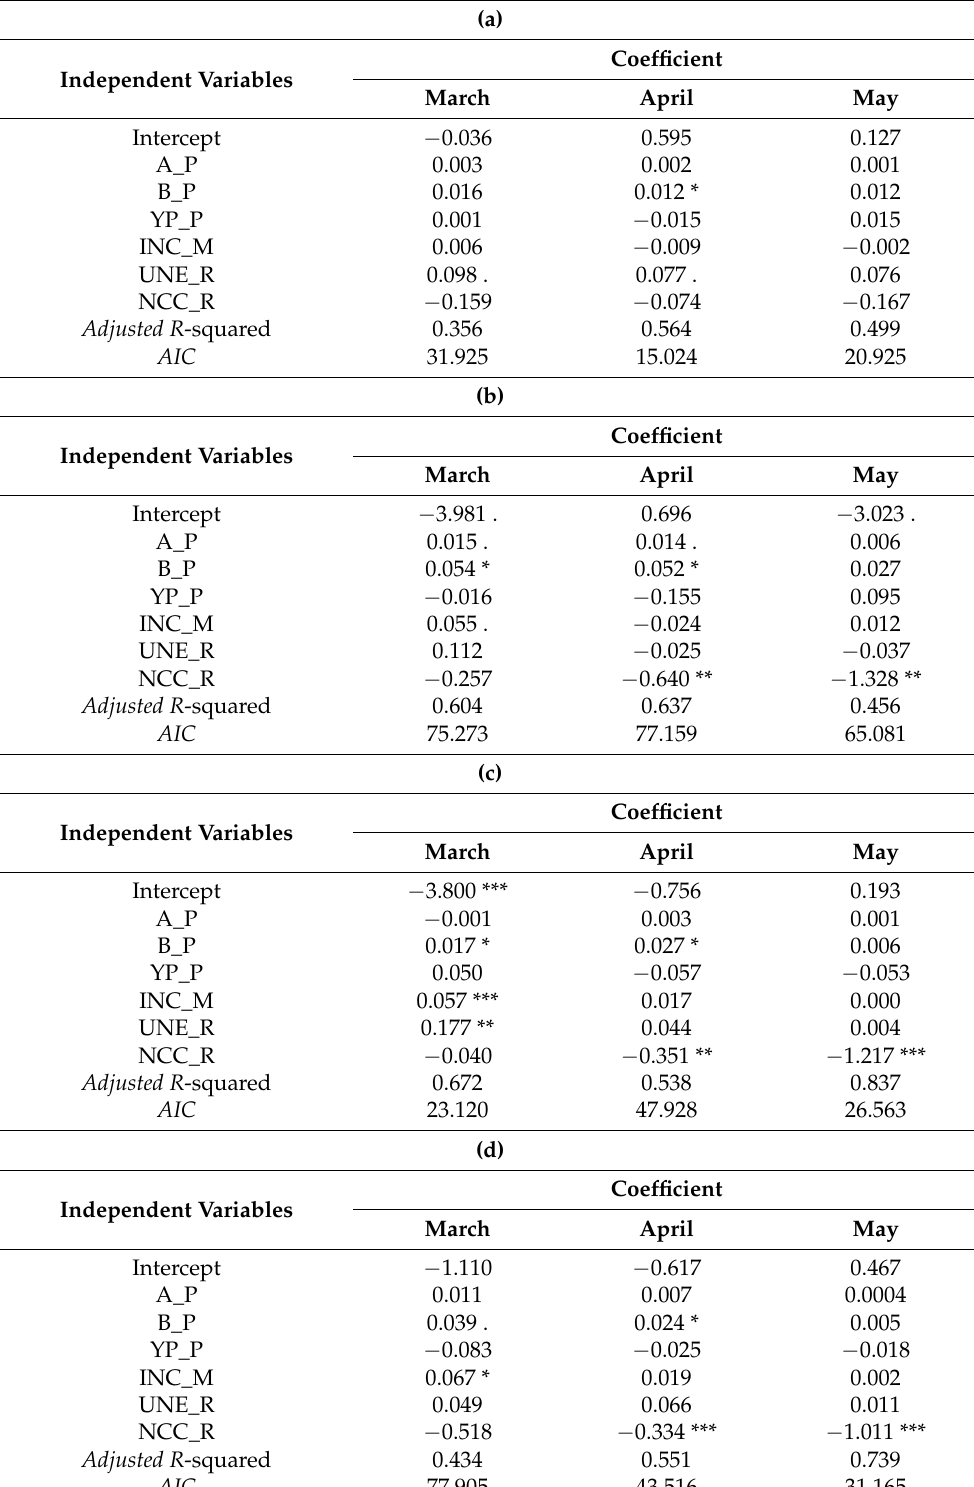
Table 5. Estimation results for the regression models. ( a ) Dependent variable: Ln_VAP_R; ( b )